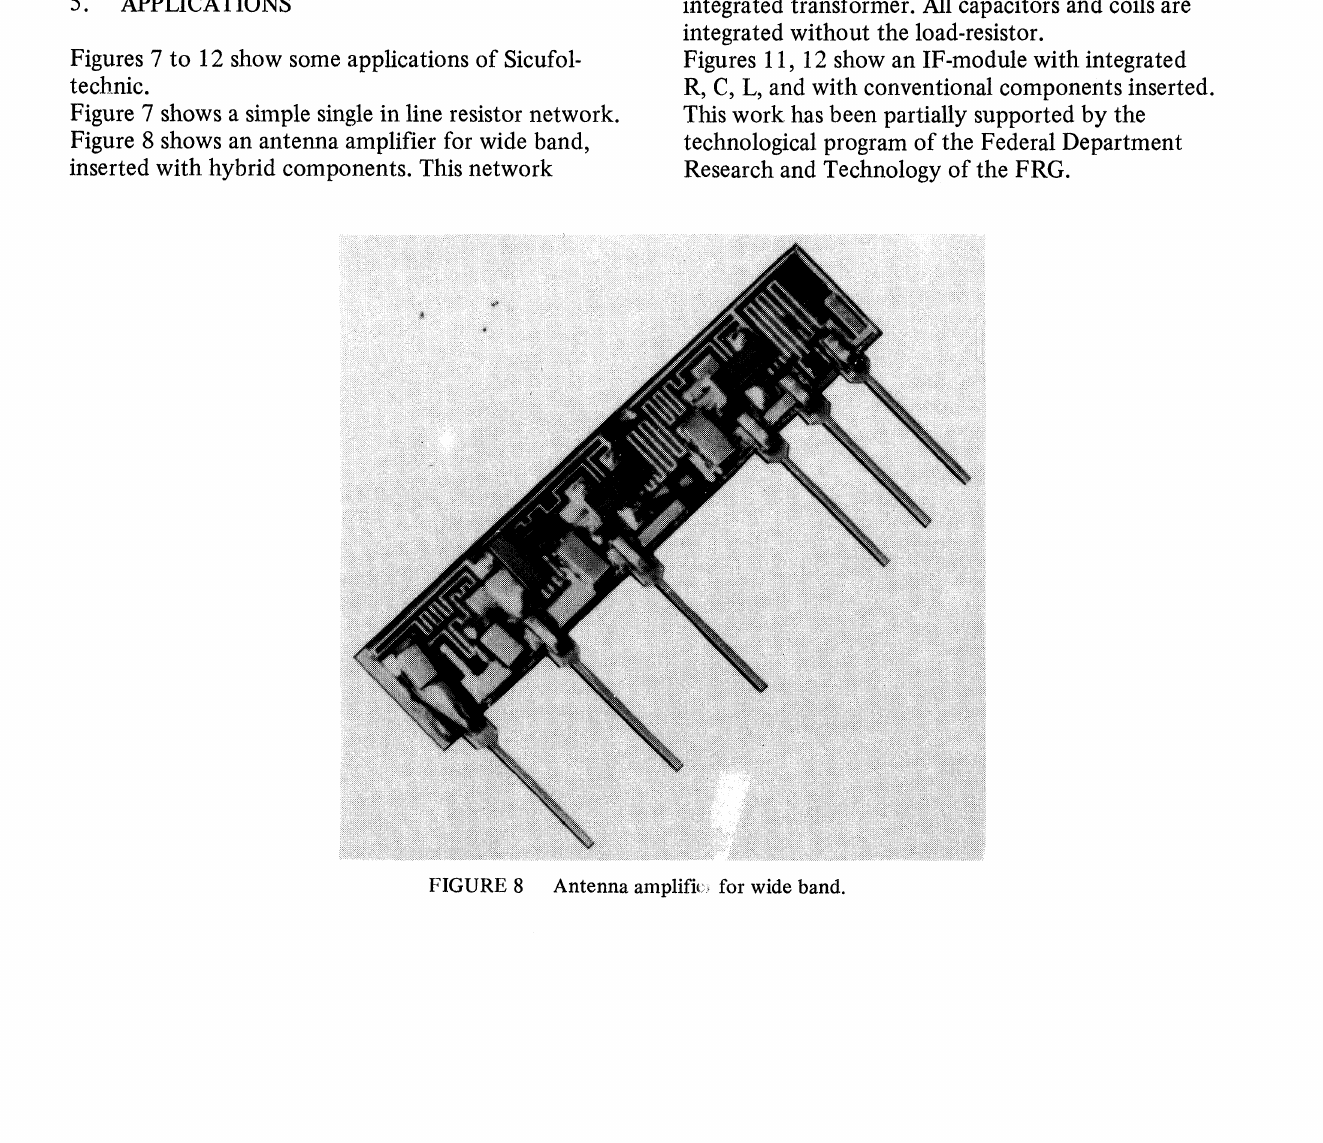
FIGURE 8 Antenna amplific for wide